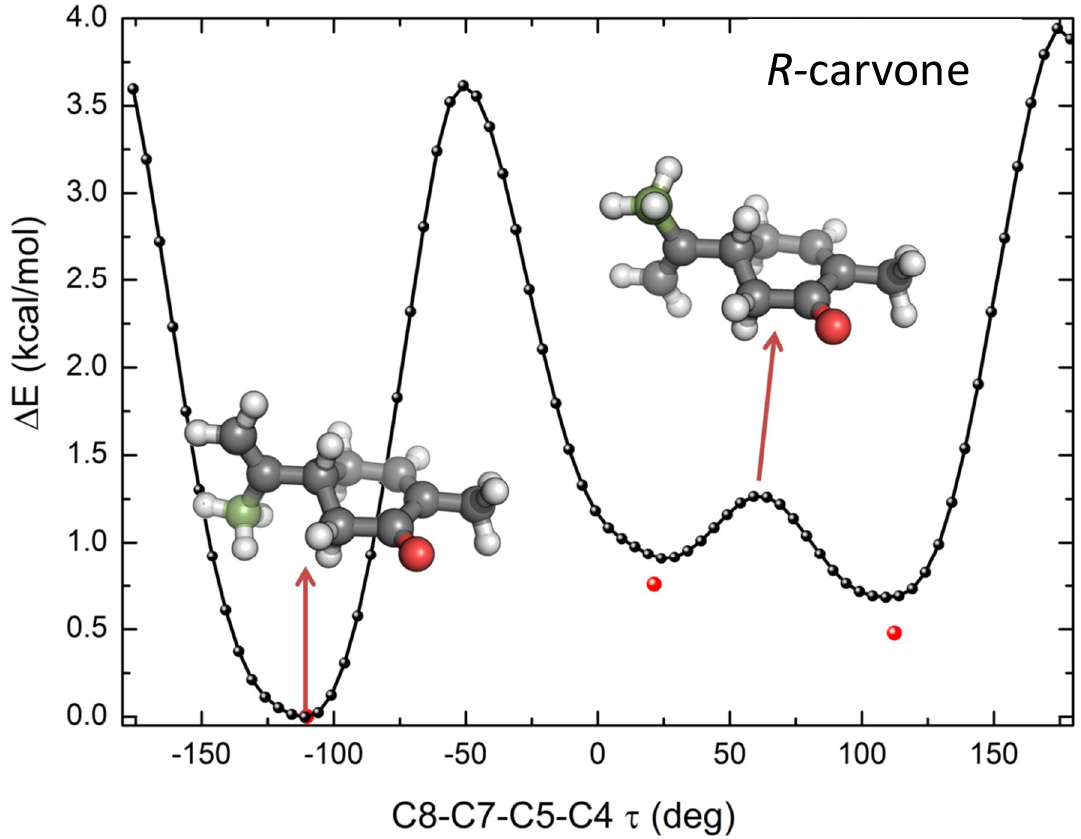
Figure 3. Scan of the potential energy surface calculated along the C8–C7–C4–C3 of R -carvone at a MP2/6-31+G(d,p) level of theory (black points). The minima were further optimized at a MP2/6-311++G(d,p) level of theory and their relative energies are also shown as red points. The structures corresponding to the global minimum and the transition state between the two local minima are shown as spheres (red (O), white (H), grey (C), to highlight the difference between both conformers C9 is shown in green). (See text for further details).